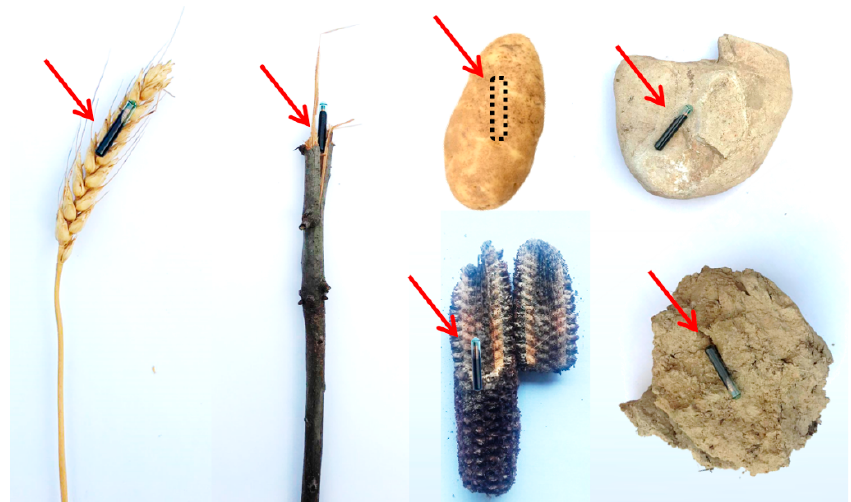
Figure 8. Suggested applications for the use of Radio-Frequency Identification (RFID) to simulate or monitor crop residues, straw, soil clods and potato in agricultural experiments.